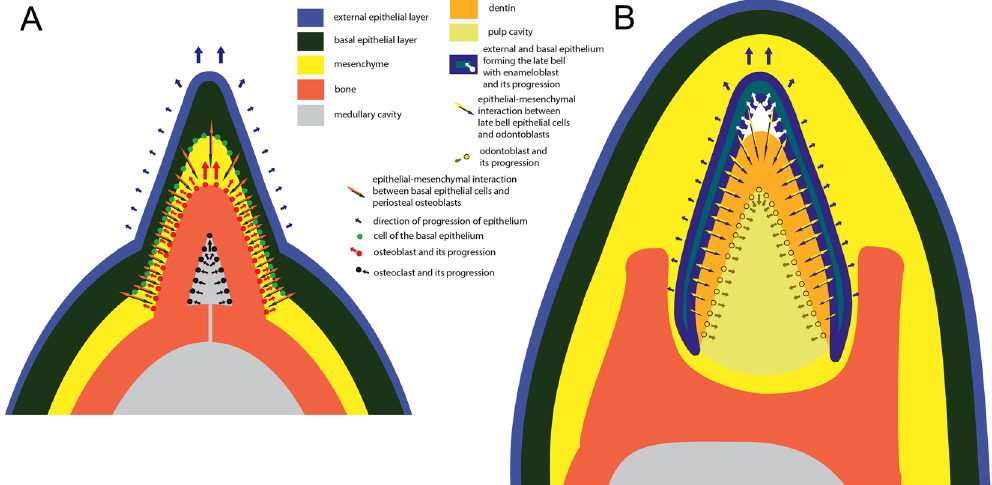
Figure 3. Proposed model of pseudotooth development compared with that of a tooth. Schematized transverse jaw section across a pseudotooth ( A ) and across a true tooth ( B ). In ( A ) the developing pseudotooth is shown at a growth stage approximately equivalent to that of stage 6 in Fig. 4. In ( B ) the developing tooth is shown schematically at “late bell” stage. In both instances epithelial-mesenchymal interactions are indicated, with the different categories of involved tissues, and their direction of growth. Thickness of tissues is exaggerated for convenience of visibility, especially for the